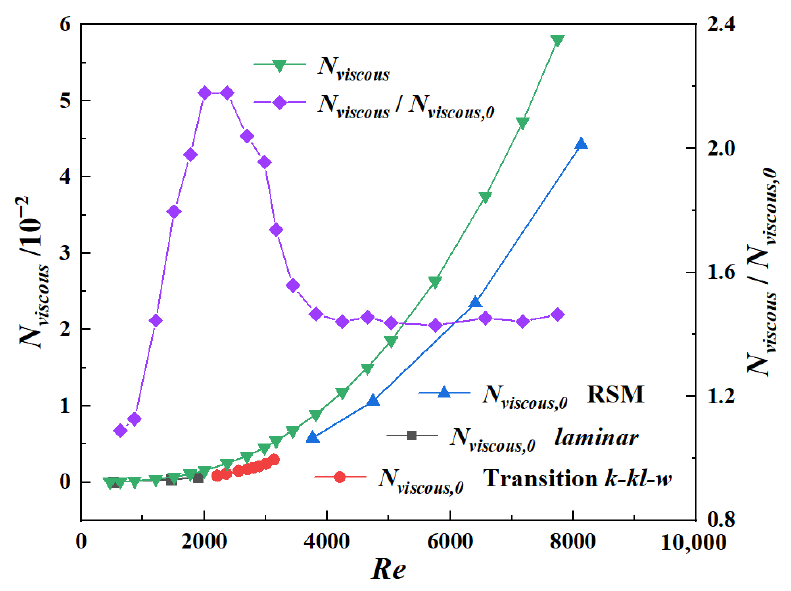
Figure 30. Variation in nondimensional frictional entropy generation rate with Reynolds number.